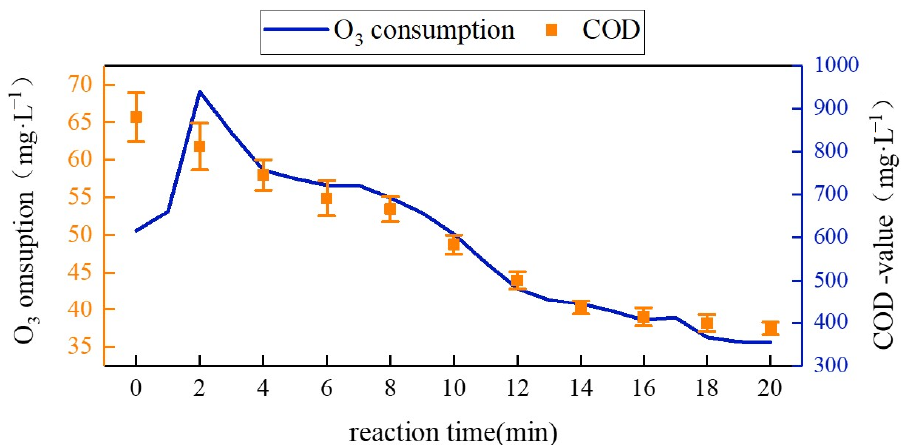
9 of 14 Figure 4. Ozone concentration (liquid) curve under the combined action of ozone (25 g·m − 3 ) and manganese dioxide as catalysts (6 g·L −1 ). 3.3. Study on Ozone Consumption and COD Removal Effect The online monitoring and data conversion system can be used to obtain the change in ozone consumption in the reaction through Equation (1), as shown in Figure 5. The overall change trends of COD and ozone consumption in the reaction are similar, and the overall trend shows a gradual decline with the reaction. At the beginning of the catalytic ozonation reaction, the ozone consumption increases sharply, with a maximum value of 69 mg·L − 1 , and gradually decreases with the progress of the reaction, with a minimum value of 36 mg·L − 1 . At the early stage of the reaction, the direct reaction and decomposi- tion reaction of ozone with pollutants are carried out synchronously, and the consump-